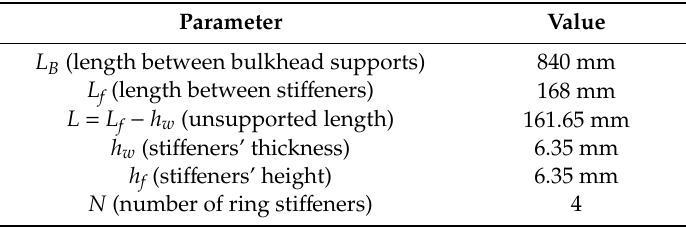
Table 2. Geometry of the conventional sti ff ened